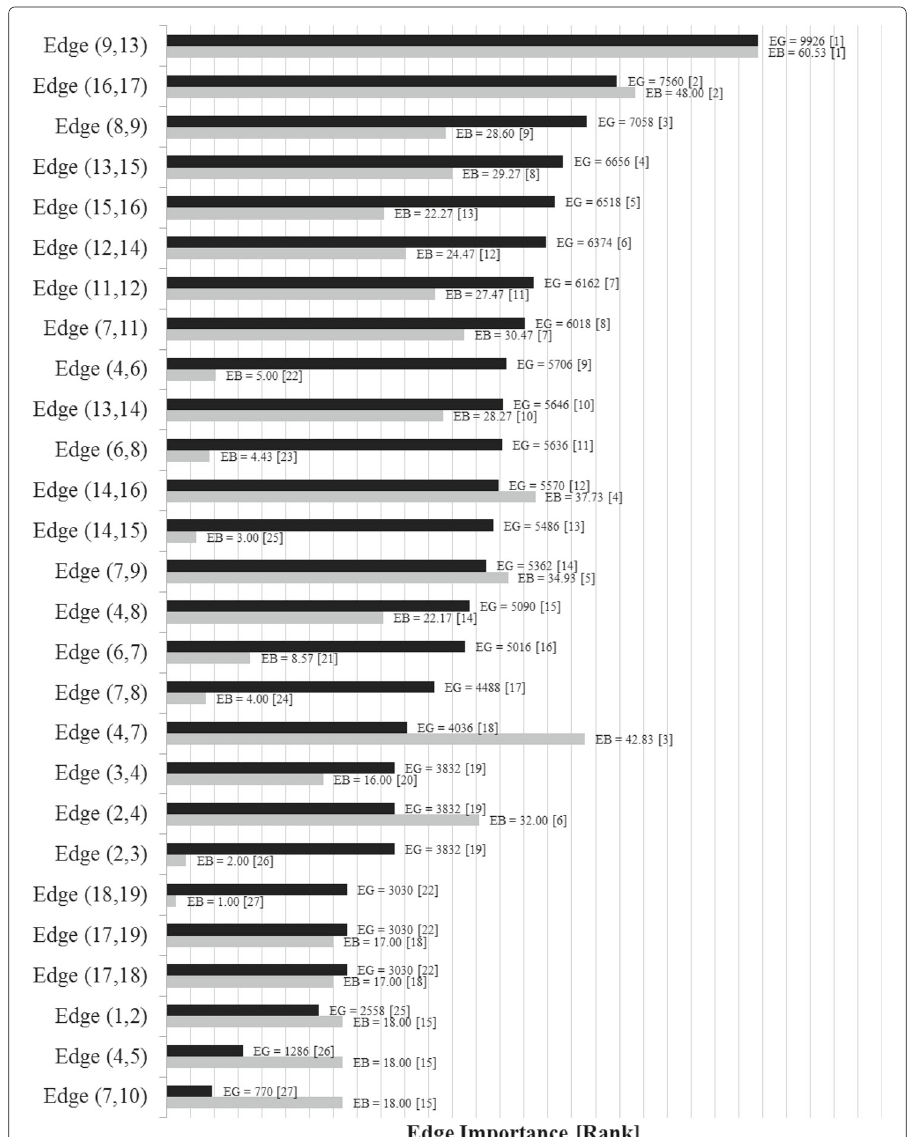
Fig. 19 Edge Gravity (EG) and Edge Betweenness (EB) solutions for the original Krebs network